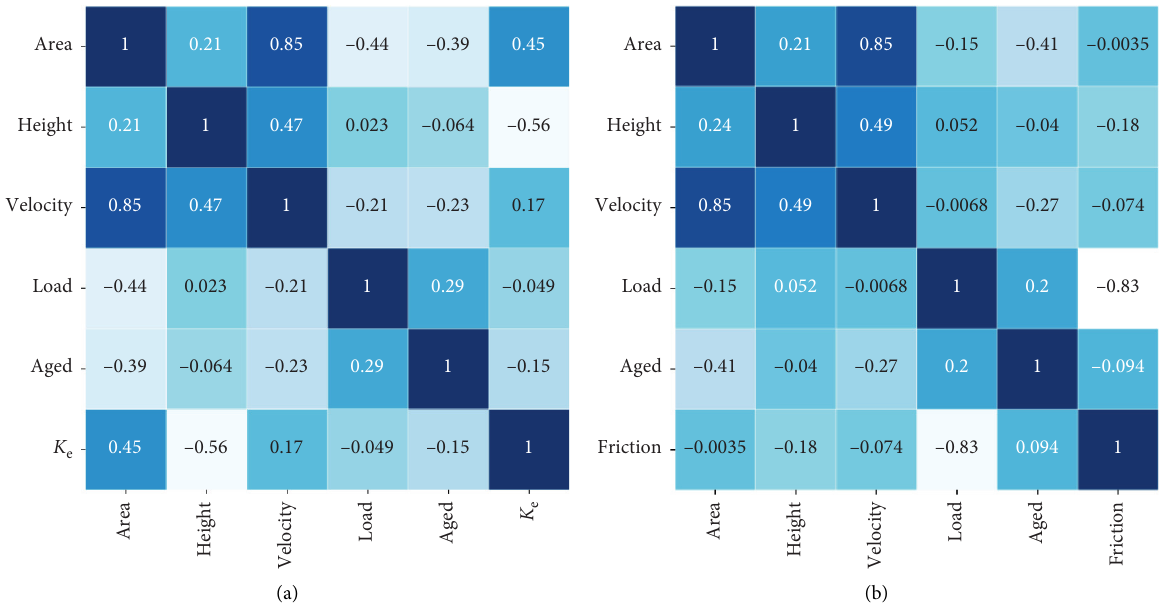
Figure 8: Correlation matrix for bearing parameters with (a) K Table 3: LRB model by the ANN.